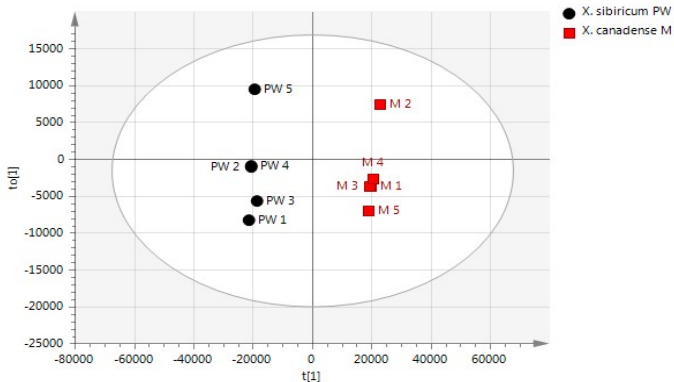
Figure 2. An OPLS-DA score plot obtained by HS-SPME / GC-TOF MS data that illustrates group similarities between X. canadense M and X. sibiricum PW . The predicted scores t versus the orthogonal scores t0 are shown.